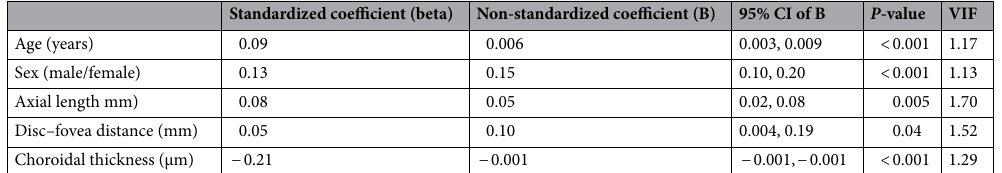
Table 4. Associations between the thickness of the ellipsoid zone (EZ) with ocular and systemic parameters in a multivariable analysis. The thickness was calculated as the mean value of all 9 Early Treatment Diabetic Retinopathy Study (ETDRS) subfields. CI confidence interval, VIF variance inflation factor.